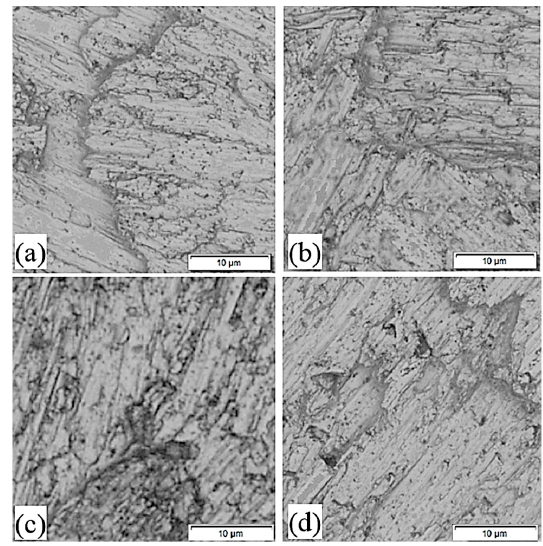
Figure 3. Morphology of the machined surfaces in different conditions: ( a ) 60 mm/min speed, feed 0.025 mm/tooth; ( b ) 60 mm/min speed, 0.075 mm/tooth feed; ( c ) 140 mm/min speed, 0.025 mm/tooth feed and ( d ) 140 mm/min speed, 0.075 mm/tooth feed.